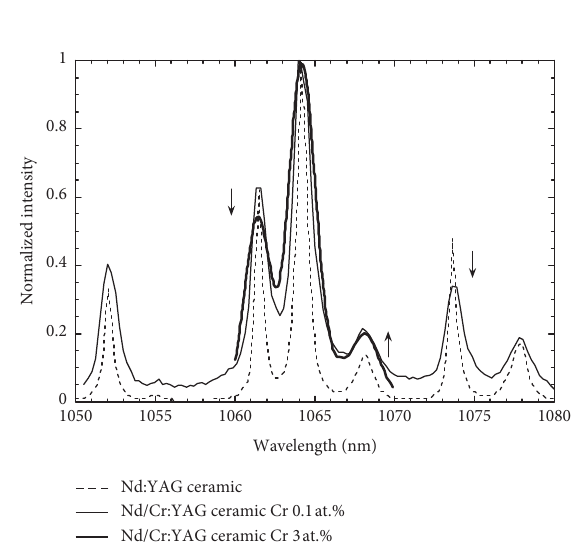
Figure 2: Fluorescence spectra of Nd:YAG and Nd/Cr:YAG ce- ramics. The doped Nd ion density was 1 at.%, and the doped Cr ion density was 0.1 or 3 at.%.